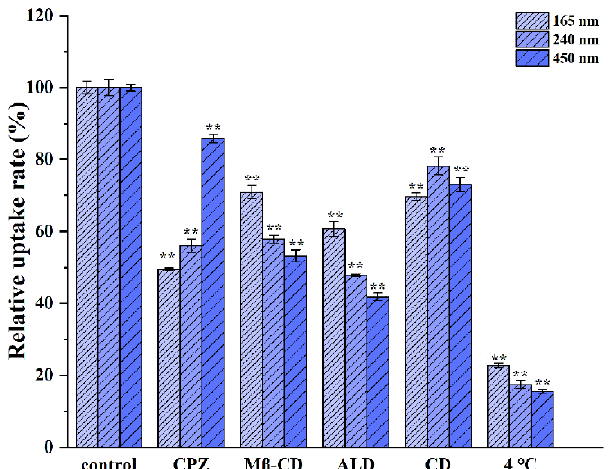
Figure 7. The relative uptake rate of different-sized CsA-NCs after inhibitor treatments in Caco-2 cells. Cells were separately pretreated with CPZ, M β -CD, ALD and CD for 30 min before the addi- tion of CsA-NCs at 37 °C for 2 h or only treated with CsA-NCs at 4 °C for 2 h (Mean ± SD, n = 3). Abbreviations: CPZ, chlorpromazine hydrochloride; M β -CD, methyl- β -cyclodextrin; ALD, ami- loride; CD, cytochalasins D. ** represents extremely significantly different with control ( p < 0.01).